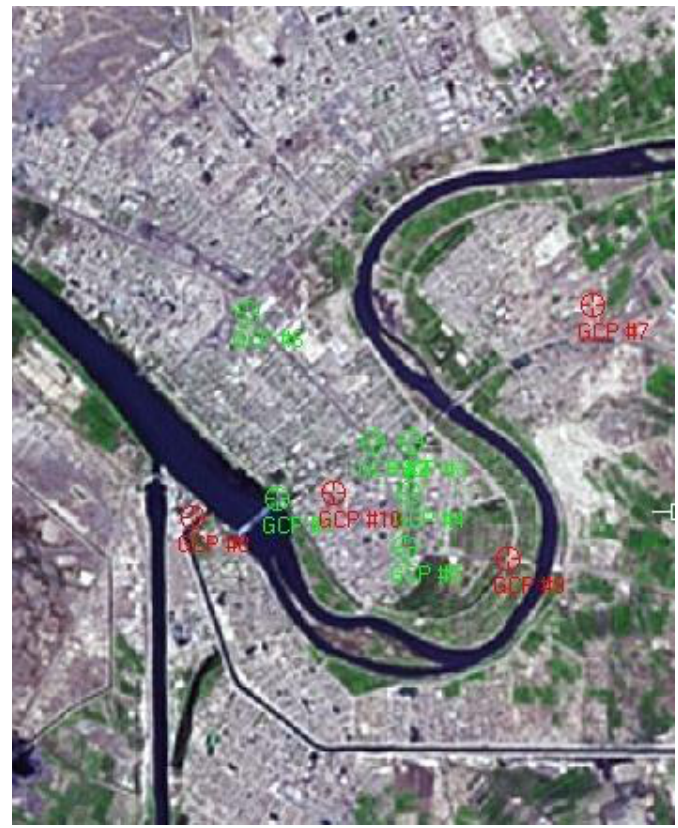
Fig. 7: The location of GCPs & check points for low resolution image. Table 4: The coordinates of 6 points and their residual errors for low resolution satellite